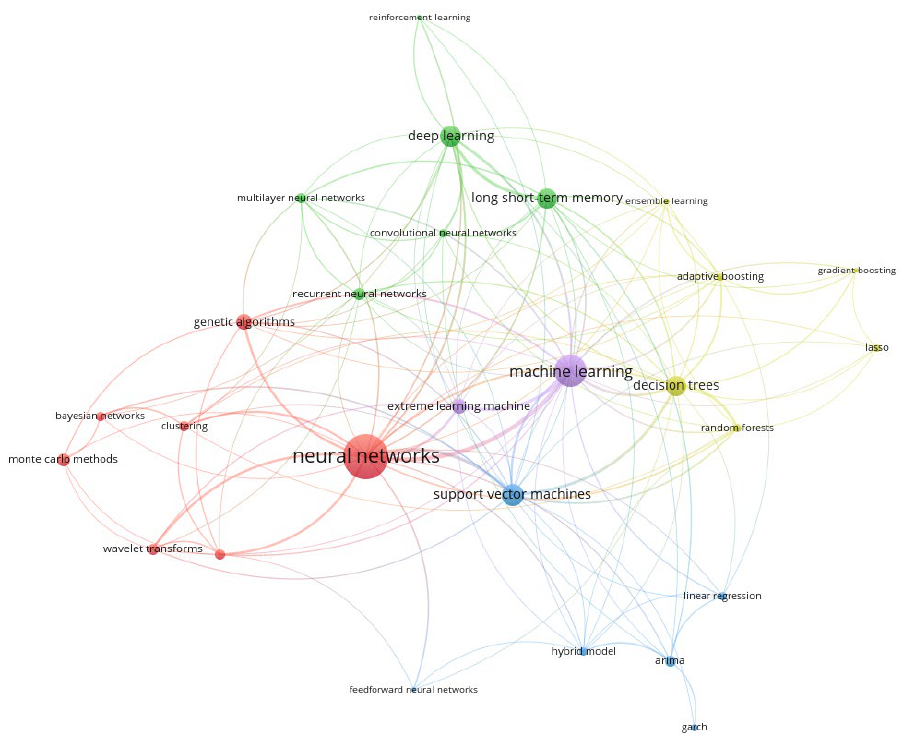
Figure 2. Bibliometric map of keywords co-occurrences results from Scopus based on original Query 1. Source: Authors’ elaboration performed in the VOSviewer (version 1.6.18).